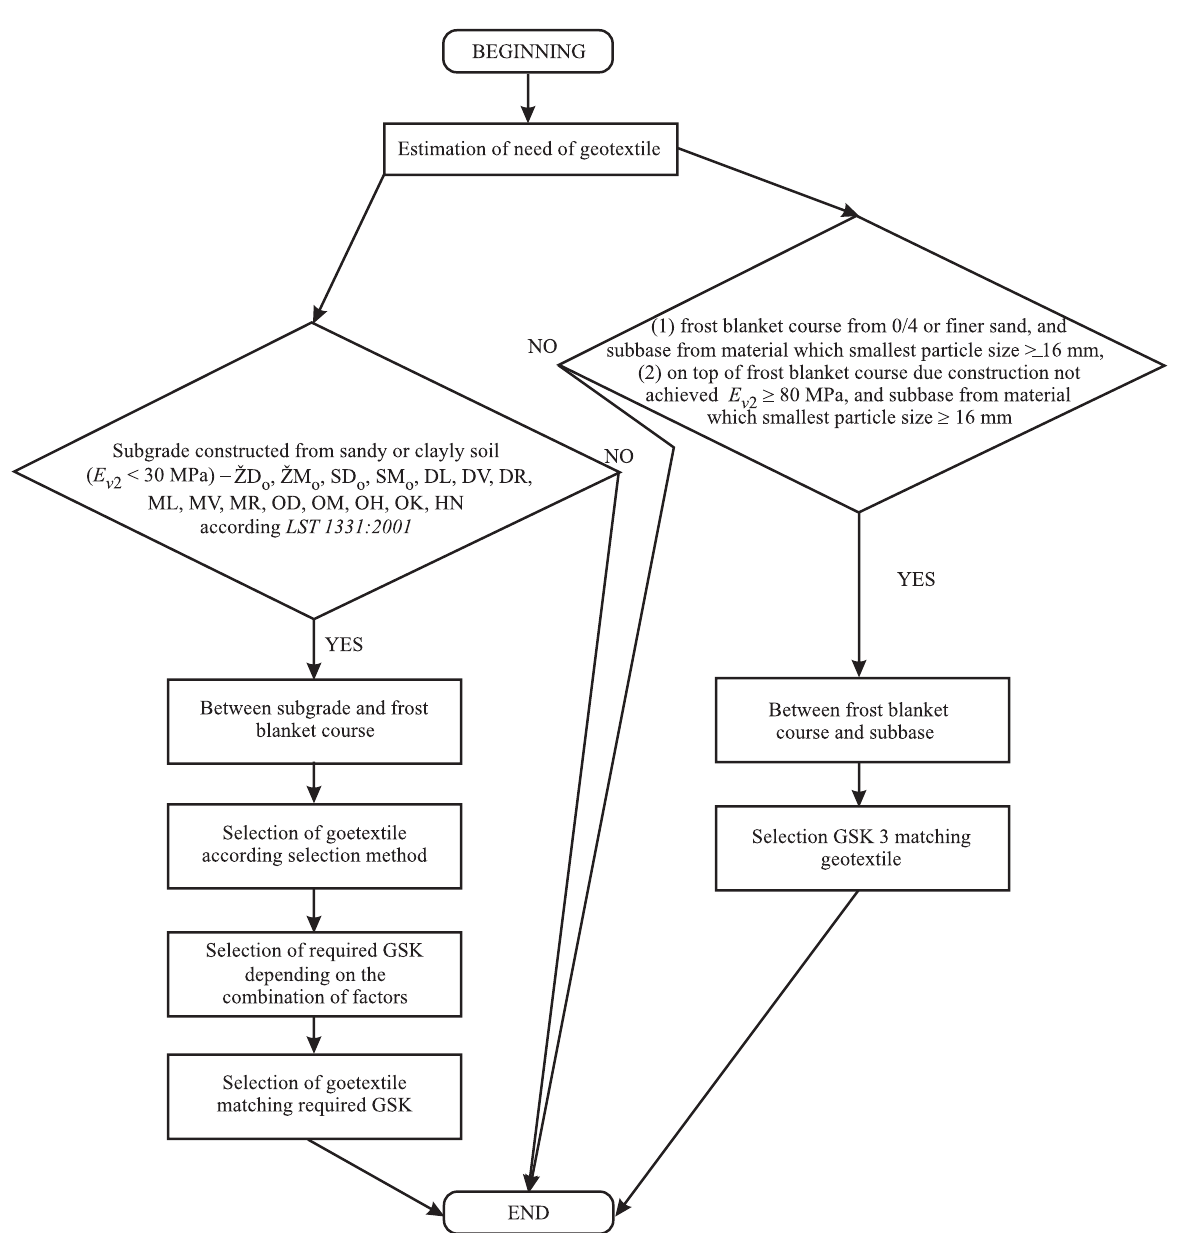
Fig. 2. Procedure for the determination of the need for the use of geotextiles and for the selection of